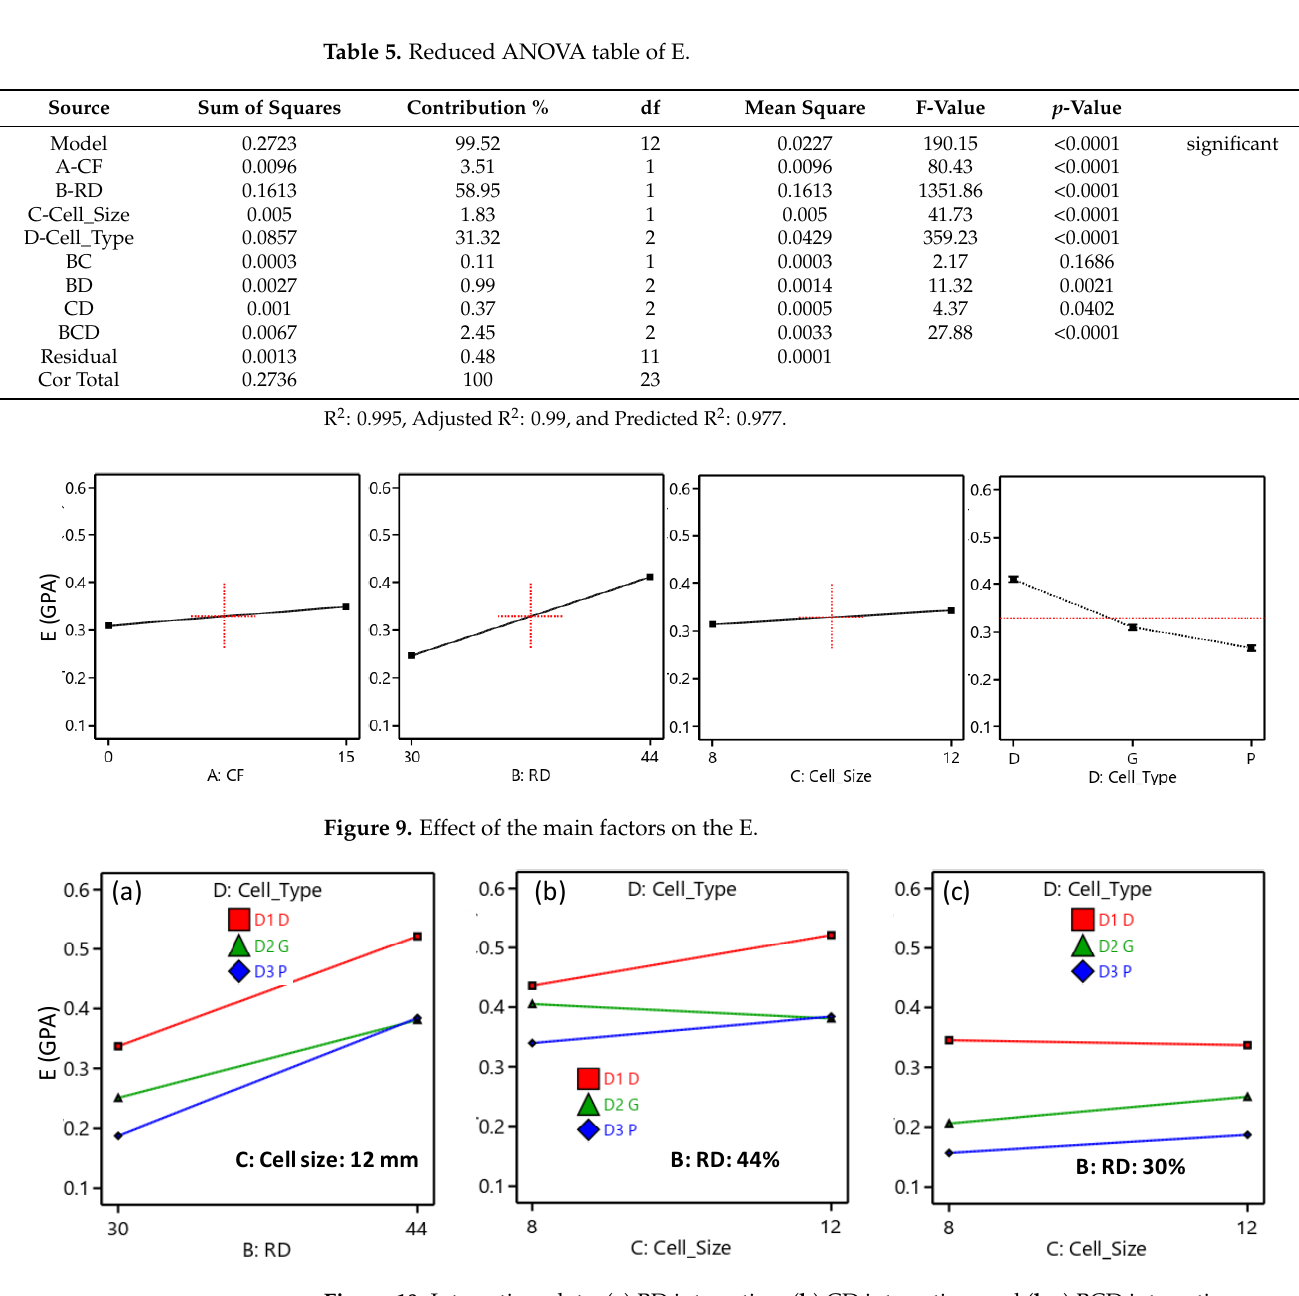
Table 6. Reduced ANOVA Table of σ peak. Source